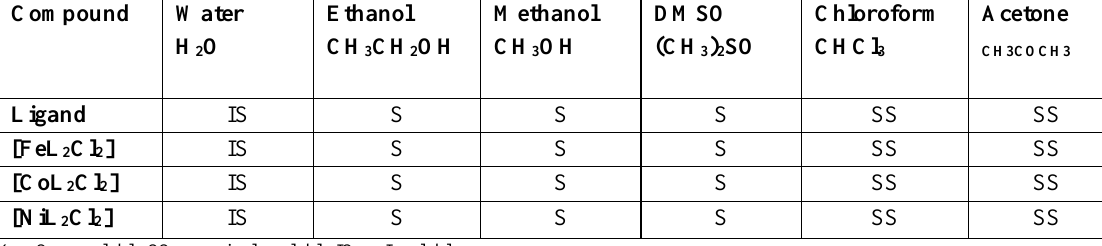
Key S = soluble SS = sparingly soluble IS = Insoluble Table 3. Magnetic susceptibility of metal (II) complexes.